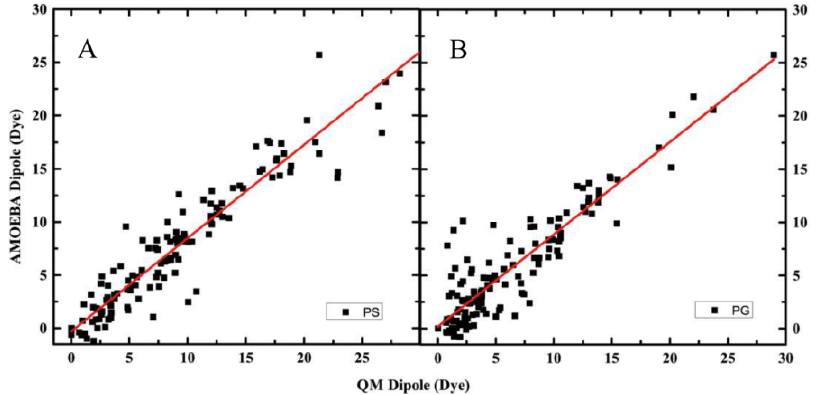
Figure 3. Comparison of torsional conformation energies predict by AMOEBA and QM (MP2/6-31G(d,p)). ( A ) Comparison of torsional conformation energies predict by AMOEBA for PS headgroup and QM; ( B ) Comparison of torsional conformation energies predict by AMOEBA for PG headgroup and QM.